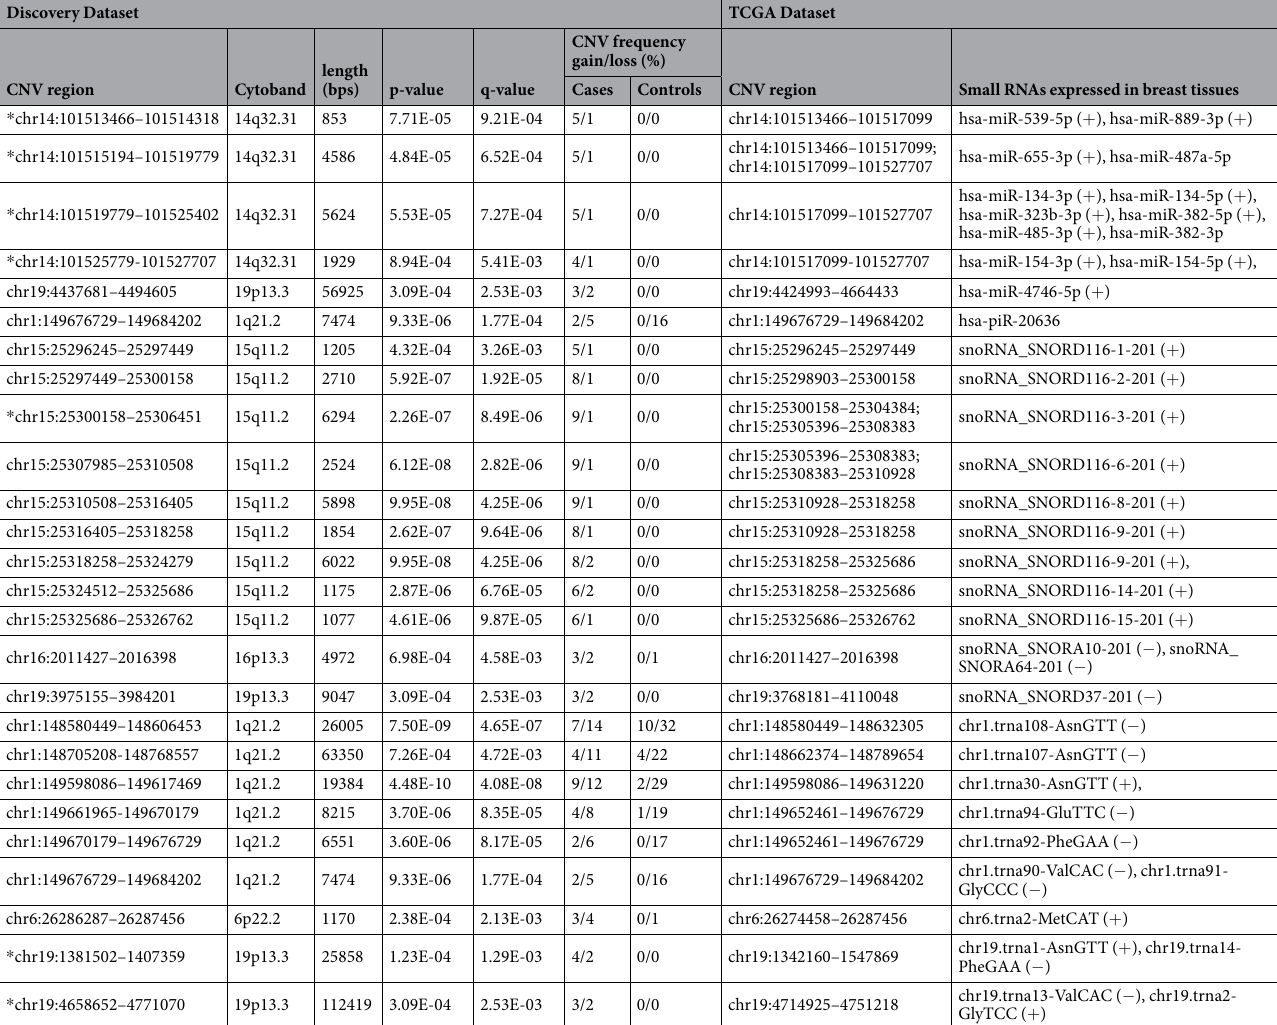
Table 1. Germline CNVs in discovery cohort showing association with breast cancer risk and expression of embedded small RNAs in breast tumor tissues from TCGA. This table represents the selected CNV regions associated with breast cancer that also included one of the four classes of sncRNAs. The statistics represented in this table is based on the discovery dataset (cases/control = 686) and includes the CNV region mapped in validation dataset (TCGA). These sncRNAs were expressed in the breast tissue (either breast tumor or adjacent normal tissues or both) in the TCGA dataset. The rows marked with * symbol indicates the CNVs that are also seen as copy number variable regions in 1000 genomes Phase 3